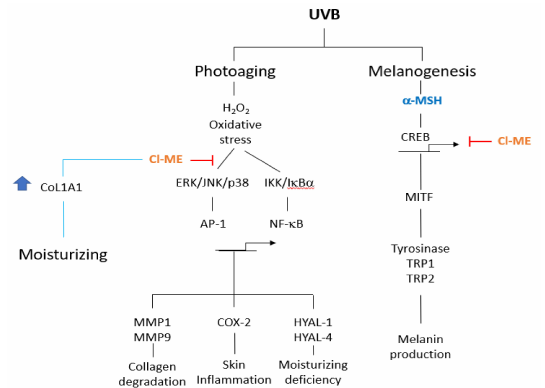
Figure 6. Schematic pathway illustrating the moisturizing, antiaging, anti-inflammatory, and an- timelanogenic effects of Cl-ME in vitro. Upon UVB, H 2 O 2 , or α -MSH stimulation conditions, AP-1, NF- κ B, and CREB pathways are initiated. By these pathways, expression of MMPs, COX-2, HYALs, and tyrosinase is increased, leading to skin inflammation, collagen degradation, and moisturizing deficiency, as well as pigmentation. Cl-ME plays its role in moisturizing, antiaging, anti-inflammatory, and antimelanogenic effects by targeting AP-1, NF- κ B, and CREB